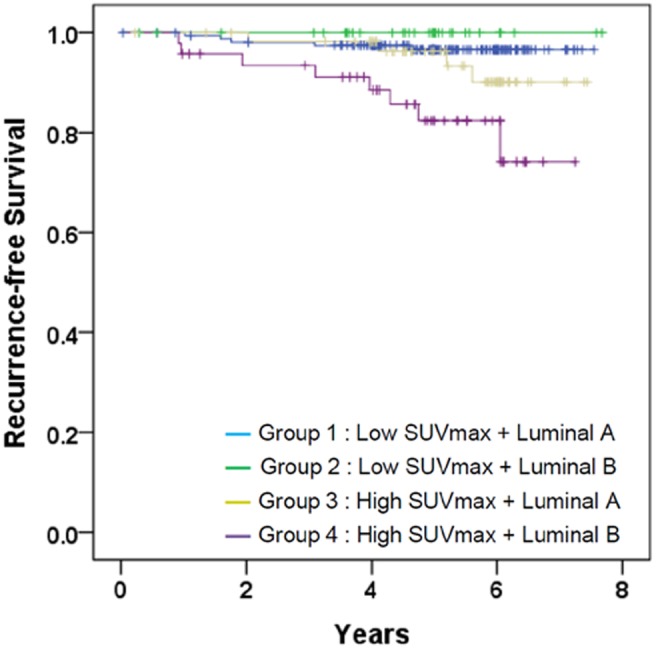
Kaplan-Meier plots stratified by combined factors with SUVmax and the intrinsic subtype: Group 1, low SUVmax and luminal A (n = 163); Group 2, low SUVmax and luminal B (n = 35); Group 3, high SUVmax and luminal A (n = 60); Group 4, high SUVmax and luminal B (n = 47).
P-value calculated by the log-rank test was 0.001.